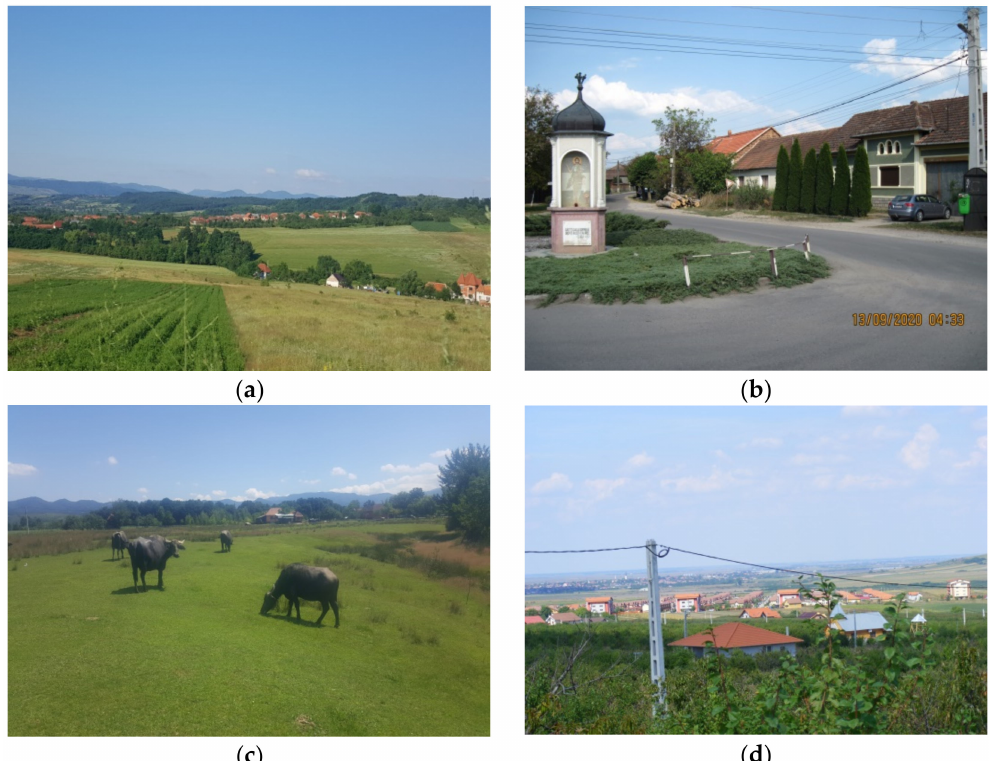
Figure 4. Representing nature as “a place around us” but also as a “place of harmony” between purely natural and anthropic elements: ( a ) Village of S ă ucani; ( b ) Village of Fini¸s; ( c ) Village of Meziad; ( d ) Village of